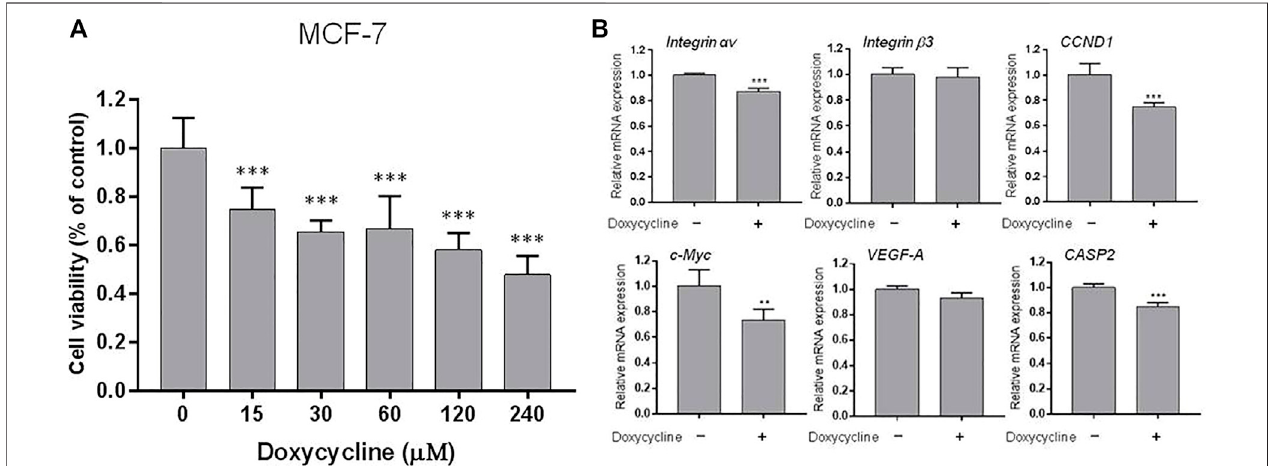
FIGURE 1 | Doxycycline induces anti-proliferation and gene expression in ER-positive breast cancer cells: (A) MCF-7 cells were seeded in 96-well plates and treatedwithdifferentconcentrationsofdoxycycline(0,15,30,60,120,240 µM)for72 h.Cell via bilitywasexaminedwithanalamarBlue ® assay.N=6.ANOVAwasused toassessstatisticalsigni fi cance.Datawereexpressedasmean±SD;*** p < 0.001,comparedtotheuntreatedcontrol; (B) Cellswereseededin6-wellplates.Then,cells were starved for 24 h and treated with doxycycline (120 µM) for 24 h. Total RNA was extracted and qPCR analysis was performed. The number of independent experiments ( n ) = 3. A Student ’ s t-test was used to assess statistical signi fi cance. Data were expressed as mean ± standard de via tion; ** p < 0.01, *** p < 0.001, compared to the untreated control.